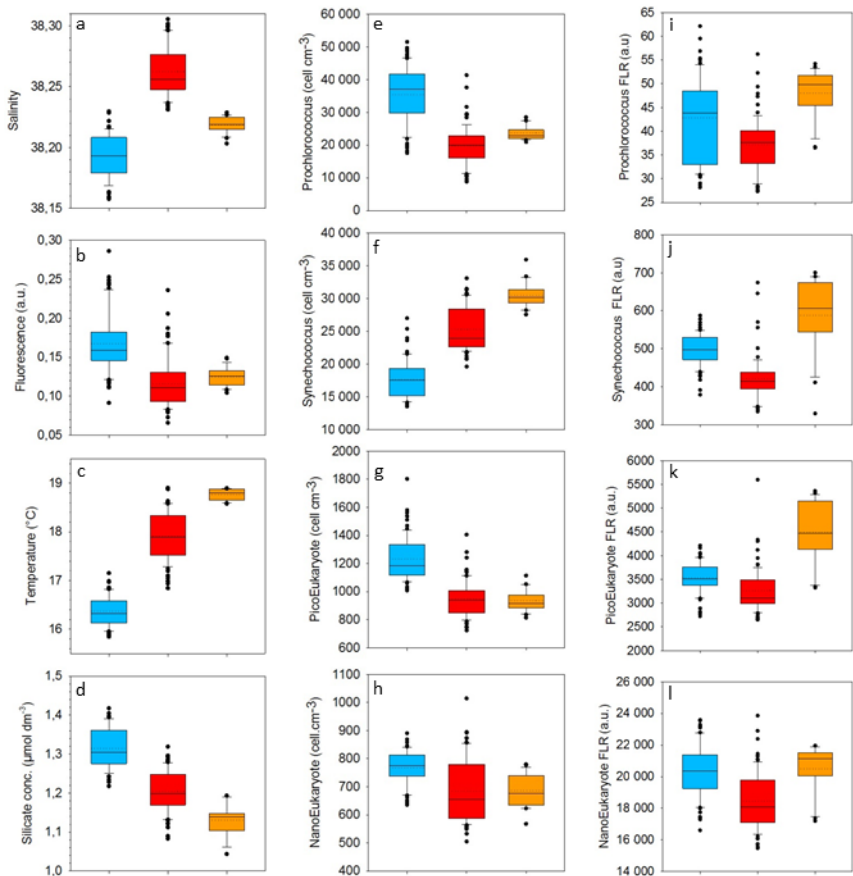
Figure 11. Boxplots of SSS, fluorescence (in a.u.), SST (in ◦ C) and silicate concentration (in µmoldm − 3 ) in cold core (in blue) and warm boundary 1 (in red) and 2 (in orange) surface waters. Prochlorococcus , Synechococcus , picoeukaryote (PicoE) and nanoeukaryote (NanoE) abundances (in cellcm − 3 ) and specific mean red fluorescence (FLR m ) in the same hydrographical provinces are also represented with boxplots. The boundary of the box closest to zero indicates the 25th percentile, the black line within the box marks the median, the dashed line indicates the mean and the boundary of the box farthest from zero indicates the 75th percentile. Error bars above and below the box indicate the 90th and 10th percentiles, and outlying points are represented. The number of observations on which these boxplots are based is reported in Table